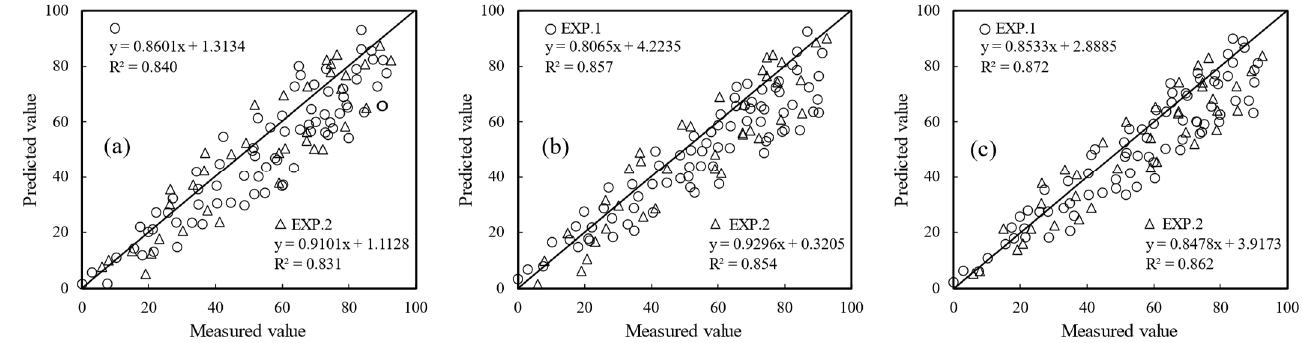
Figure 10. Comparison of three data source fusion models based on ( a ) PLSR, ( b ) SVR and ( c ) RFR algorithm.